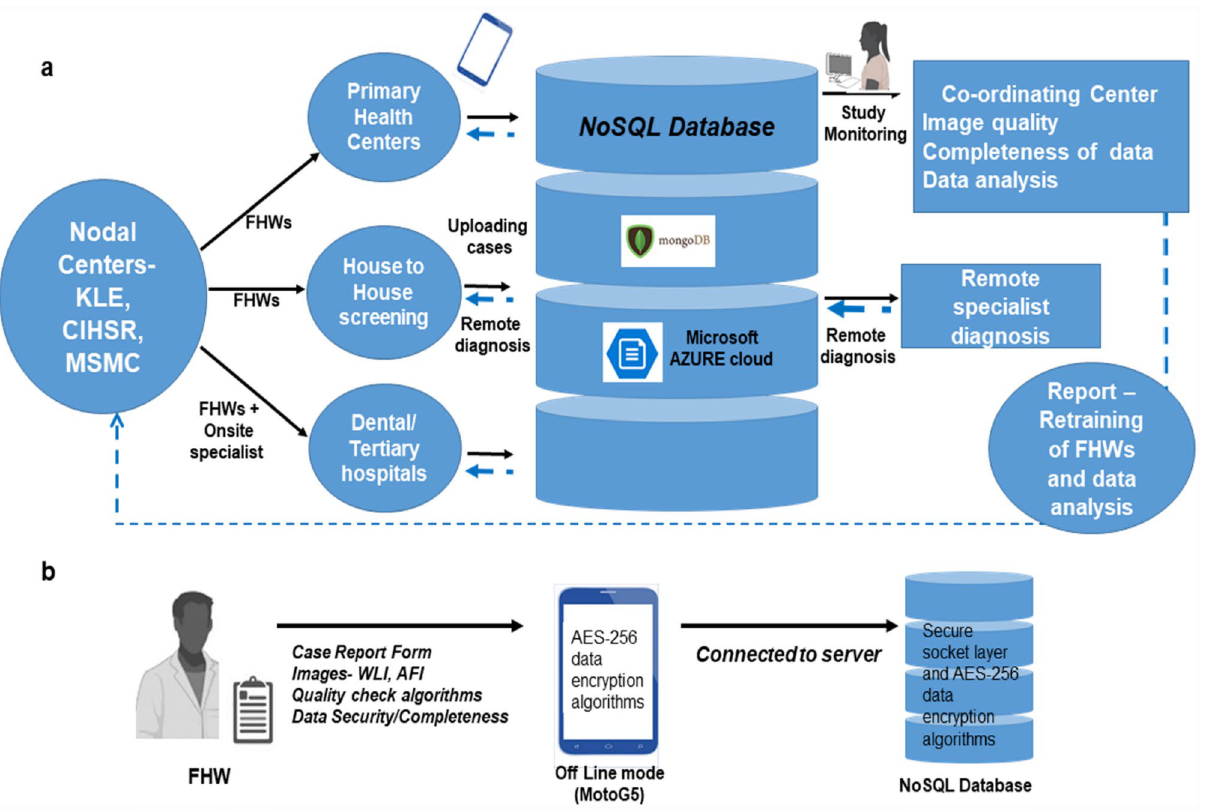
Figure 5. Hub-and-spoke model for data collection. The study nodal centers enrolled FHWs from different study populations ( a ) and participants were recruited according to inclusion and exclusion criteria. The demographics, clinical history of habits/lesions, and images were recorded using a dual-mode imaging device. Intraoral images were captured in the WLI and AFI dual-mode, a large view of the lesion was captured by phone camera, and a more focused image using probe camera by FHW ( a ). The case report form and images were uploaded by trained FHWs to Microsoft Azure Cloud ( b ). The data was stored in a NoSQL database (MongoDB) and was assessed by the study coordinator and remote specialist using the graphic user interface. The interpretation of the remote specialist was sent back to the phone operated by FHW (blue line showing reverse data flow). The study coordinator checked the completeness of data and a specialist checked the quality of images and feedback was sent to respective nodal centers bi-weekly. The data was recorded offline and an AES-256 data encryption algorithm was used to store the data in offline ( b ). FHW Front-Line-Health Worker, WLI White Light Imaging, AFI Auto-fluorescence Imaging, KLE , CIHSR, and MSMC: nodal centers. Images of FHW, Study monitoring were created with “BioRender.com” (https:// biore nder.